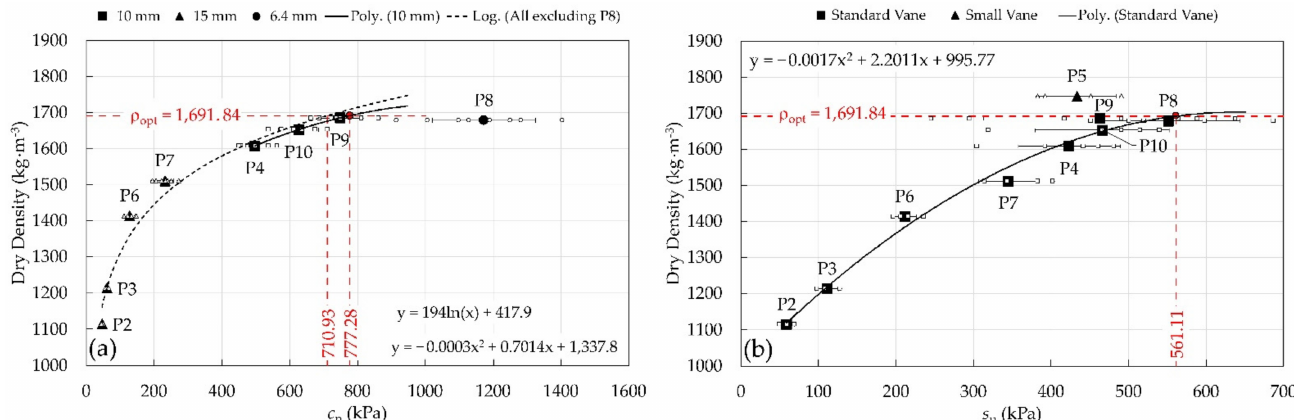
Figure 8. ( a ) Strength measurements obtained with the Geotester Pocket Penetrometer distinguished by the size of the plunger. The logarithmic regression curve was fitted to all tests except CB18-P8, and the quadratic regression curve to the tests CB18-P4, CB18-P9 and CB18-P10; ( b ) Measurements made with the Pocket Shear Vane Tester distinguished by the vane size. The quadratic regression curve is fitted using all data points except CB18-P5 as it was obtained with the smaller vane instead of the standard; In both charts, the big solid dots represent the average strength value, the small white dots represent each of the measurements, and the horizontal lines represent the extension of one standard deviation from the